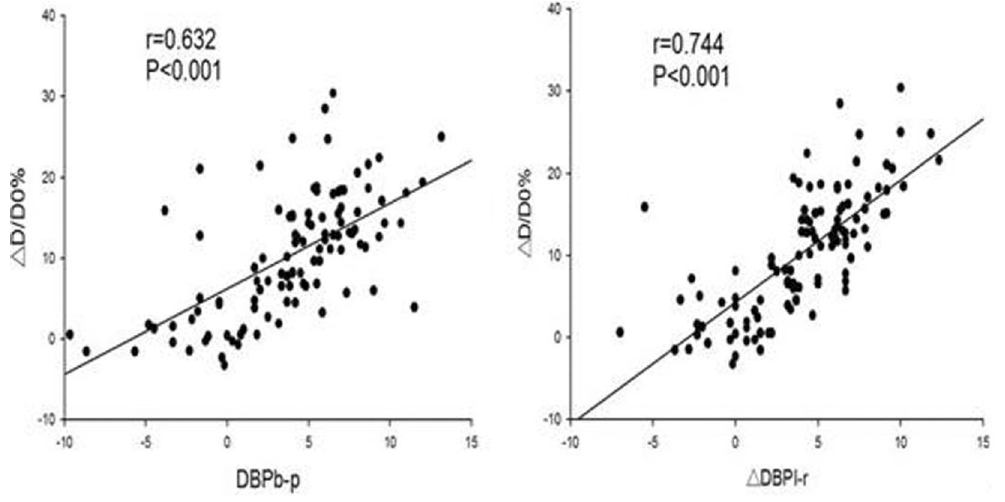
Figure 1. The correlation of D D/D0 with DBPb-p and D DBPl-r. g D: increase in artery diameter ( D D= post-D - D0). D D/D0: percentage increase in right brachial artery diameter. DBPb-p: DBP change following right-arm ischemia. D DBPl-r: DBPl-r change following ischemia. (BPl-r: DBP difference between left and right arms). doi:10.1371/journal.pone.0084765.g001 PLOS ONE |